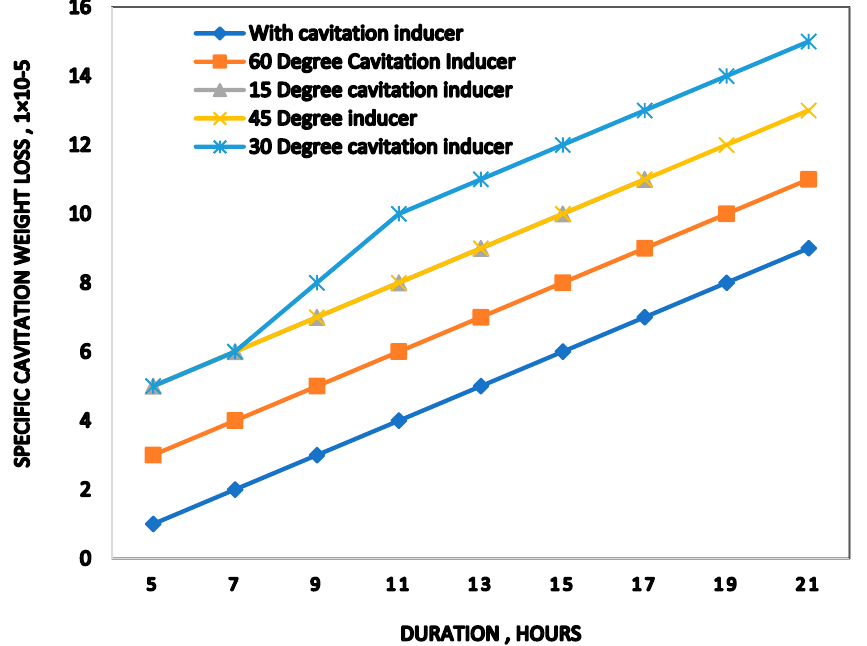
inducers Figure 12. Cumulative mass loss as a function of test duration without and with the cavitation inducers [29].